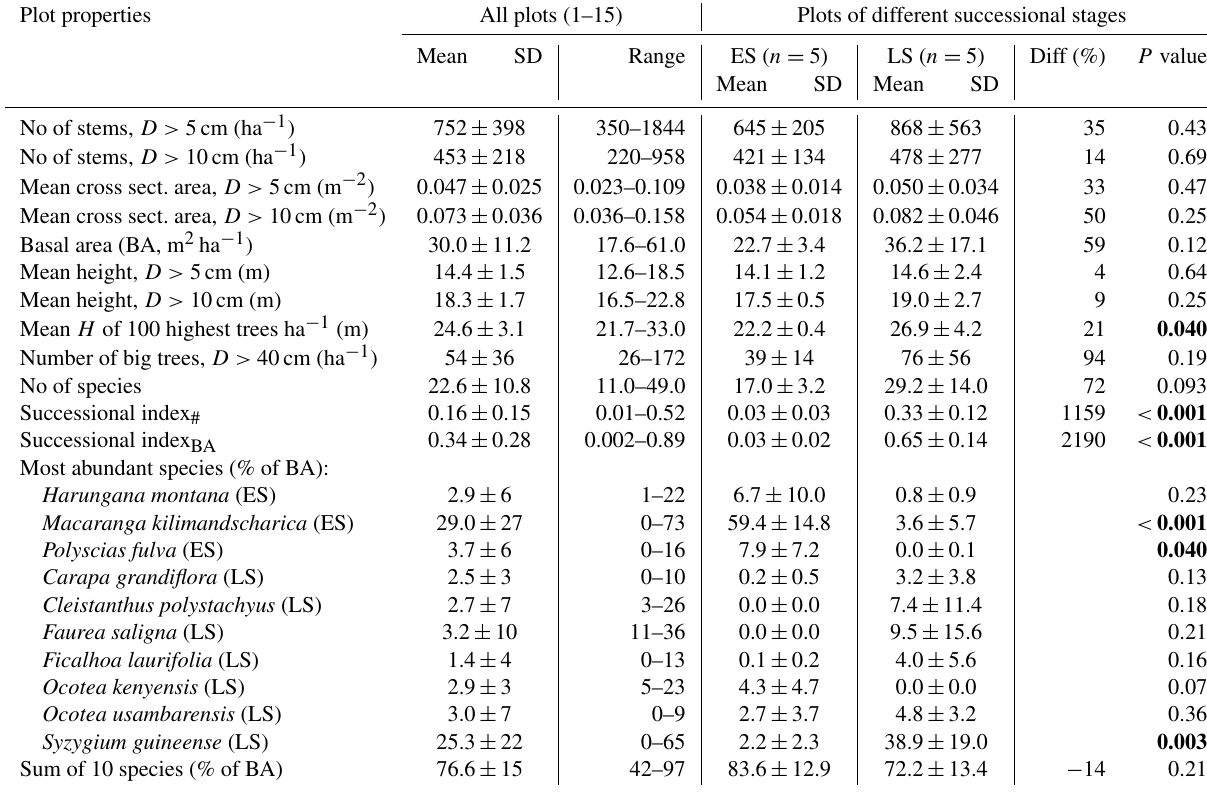
Table 2. Biomass properties and species composition (means ± SD and range) of all plots (1–15) classified as early (ES; n = 5) or late (LS; n = 5) successional. The data are based on results from the first census (2012) of all stems ≥ 5cm within the plots, expect for relative growth rate, recruitment and mortality (Eqs. 6, 10 and 11, respectively) that were based on both census I and II data. The successional indices (based on number of stems, #, and basal area, BA) were calculated using Eq. (9). The listed species are used to construct the successional index and selected based on their contribution to total stand BA. Diff represents the mean % differences of LS in relation to ES plots and P values are the results of a t test of the difference between ES and LS. Bold value, P < 0 .